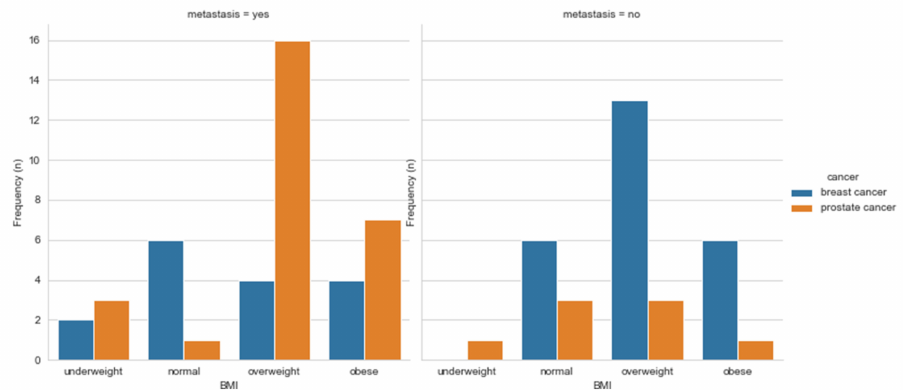
Figure 3. Population graphs for BCa and PCa BMI for metastatic and non-metastatic